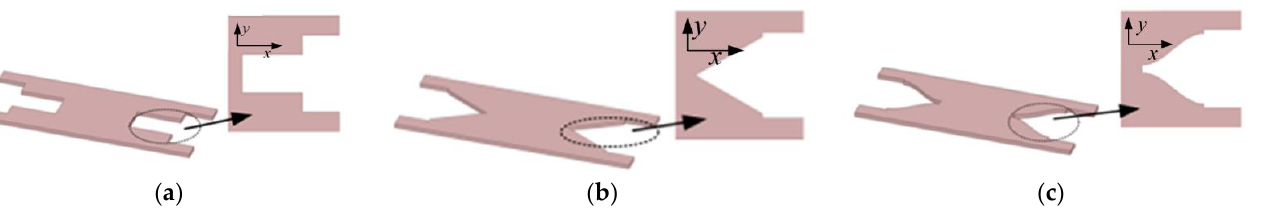
Figure 3. The shape of the inserted dielectric plate: ( a ) Rectangle. ( b ) Traditional dovetail shape. ( c ) Improved dovetail shape.